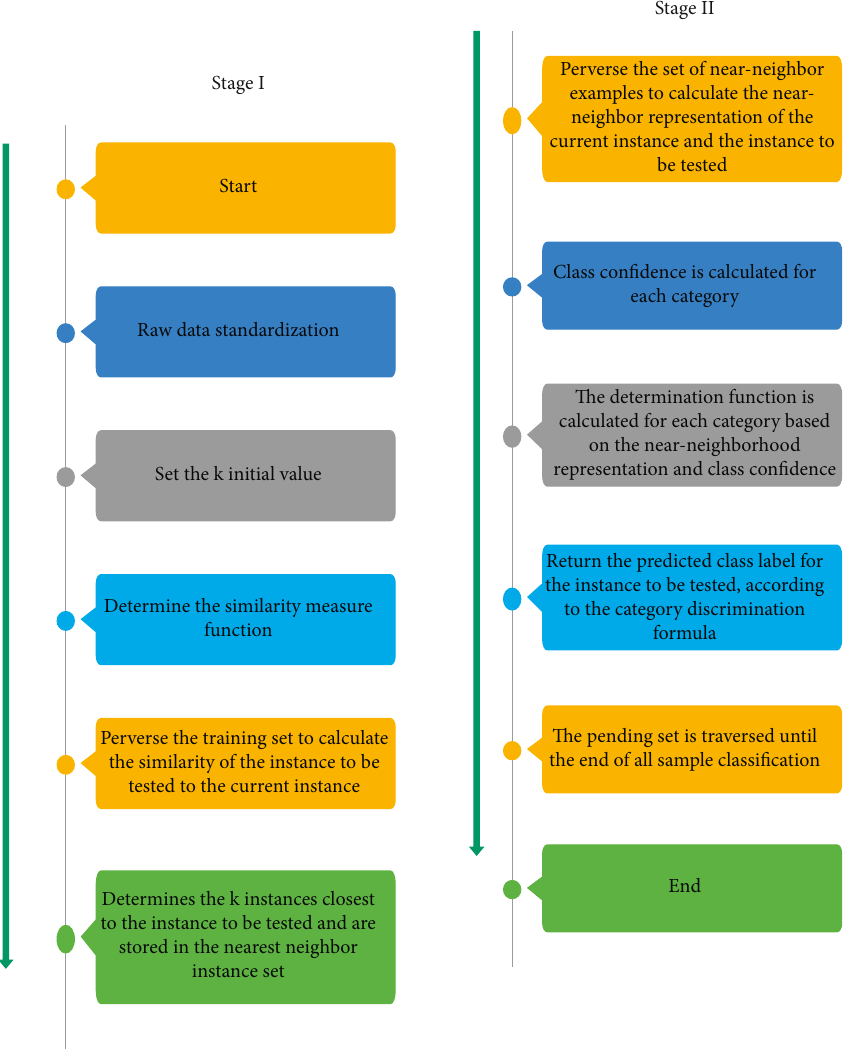
Figure 3: ND_KNN flow